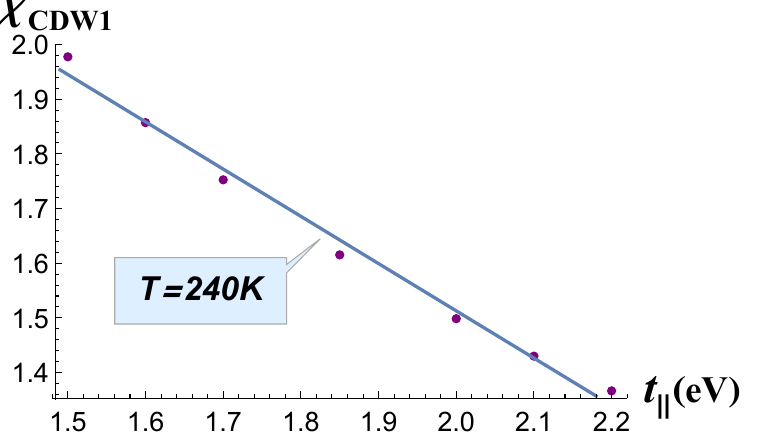
Figure 4. Electron susceptibility χ calculated at T = 240 K as a function of the electron hopping term t (cid:107)